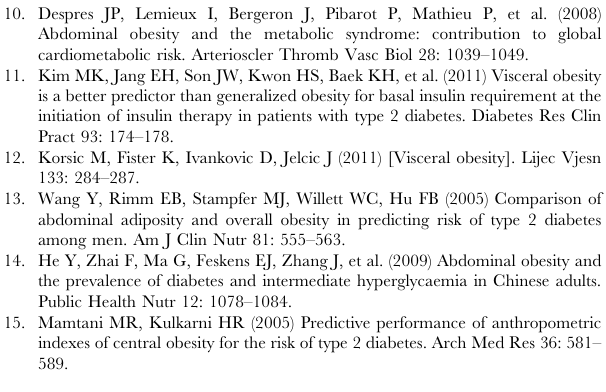
Table S1 Association of dichotomized WC with T2D- related traits before and after accounting for the use of lipid lowering